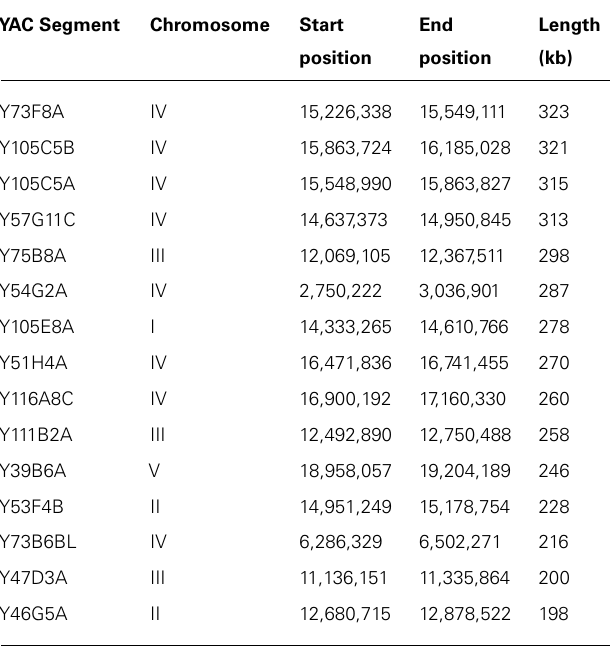
Table 3 | Longest 15YACs, their locations, and